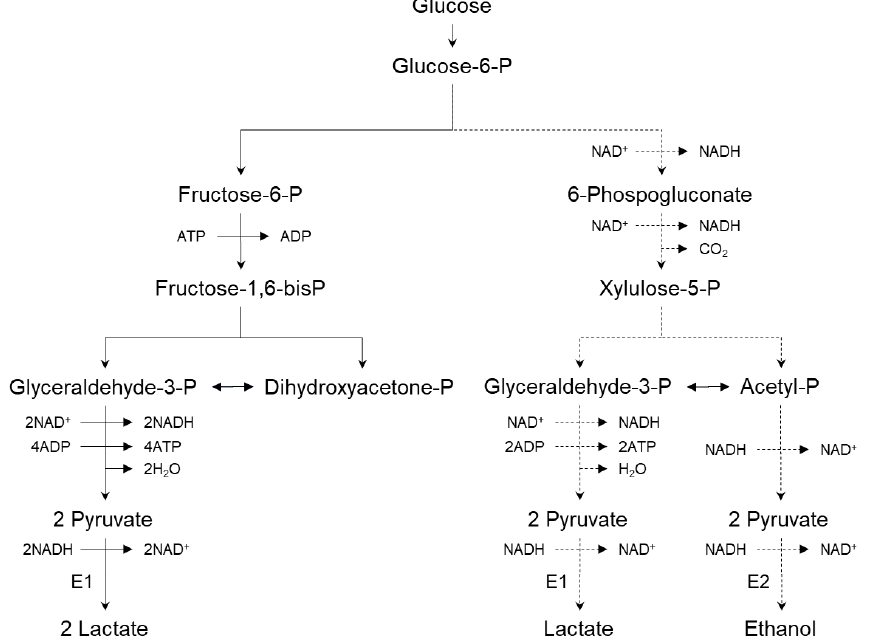
Figure 1. Metabolic pathways of homofermentative (solid line) and heterofermentative (dotted line) lactic acid bacteria. P, phosphate; ADP, adenosine 5 ′ -diphosphate; ATP, adenosine 5 ′ -triphosphate; NAD + , nicotinamide adenine dinucleotide (oxidized form); NADH, nicotinamide adenine dinucleotide (reduced form); E1, lactate dehydrogenase; E2, alcohol dehydrogenase.